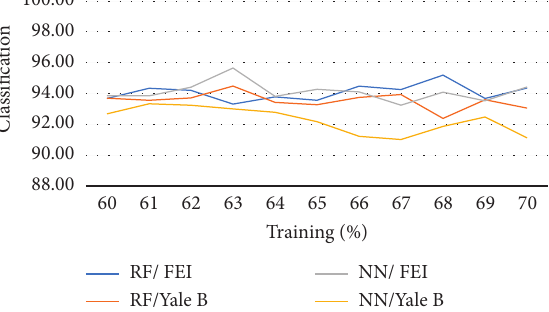
Figure 10: The classification results of the proposed method using 60% to 70% of the training data (FEI and Yale B datasets) and the classification performance of NN and RF.